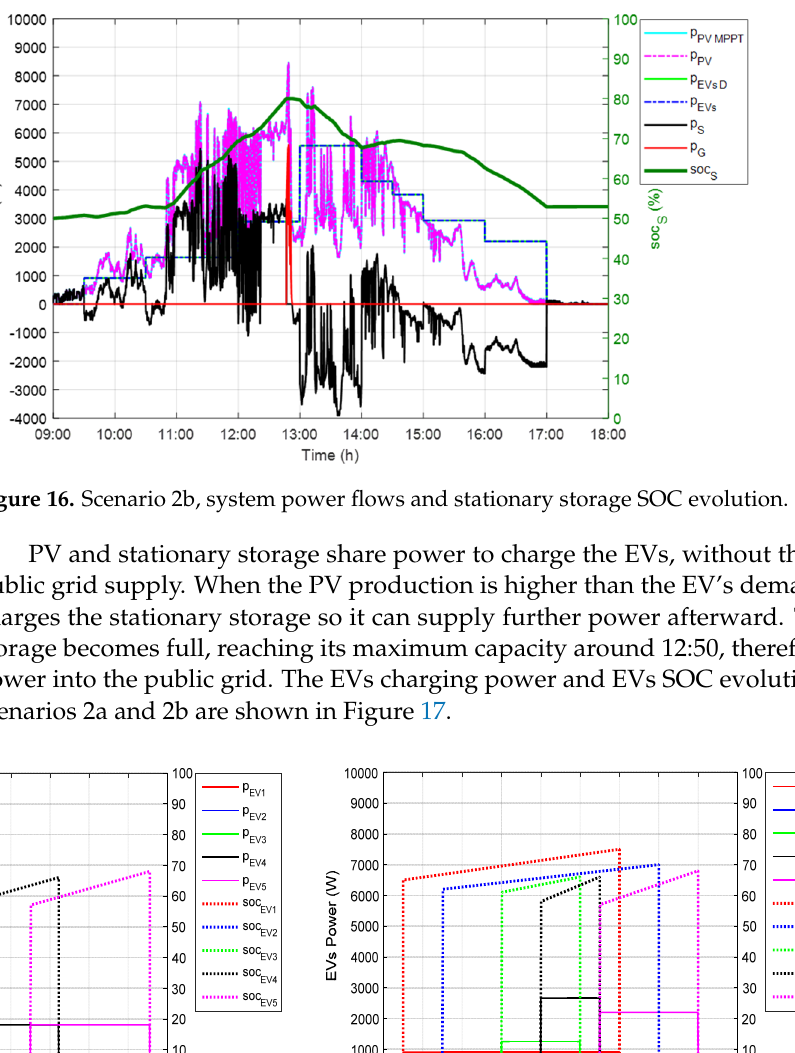
for Scenario 2b.